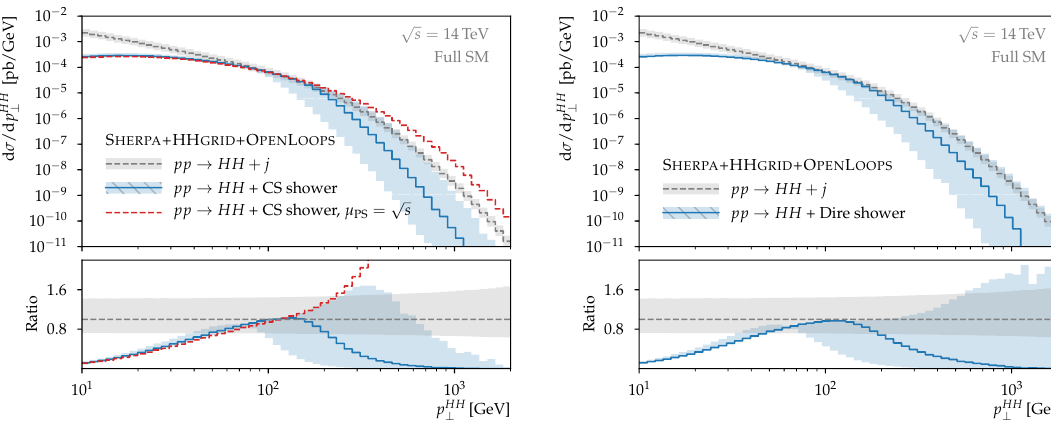
Figure 3 . Parton shower predictions for the p HH spectrum in a LO+PS type simulation compared ? to a (cid:12)xed-order calculation in the full SM. The uncertainty band around the (cid:12)xed-order result is obtained through variations of (cid:22) F and (cid:22) R . Uncertainties on the LO+PS results are obtained by varying (cid:22) PS